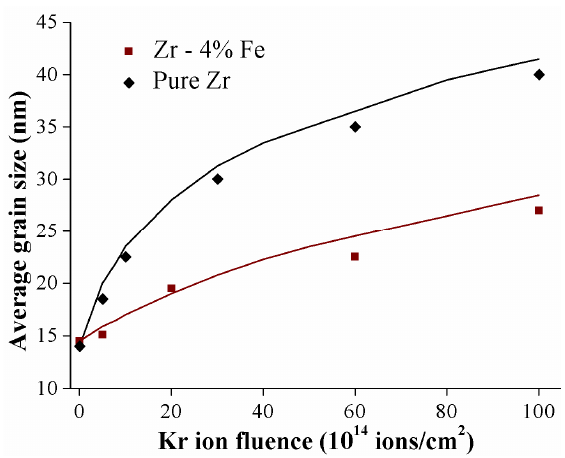
Figure 6. Average grain size versus ion fluence for pure Zr and Zr-1.2%Fe irradiated with 500 keV Kr ions at 20 K [80].